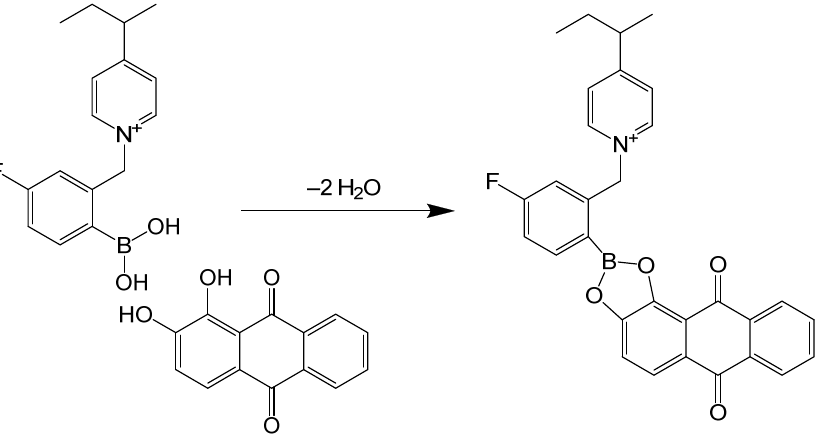
Figure 4. Cryo-TEM images of ( a ) A-SVE-FPBA (pH 5.10) and ( b ) N-SVE-FPBA (pH 7.20) micelles.